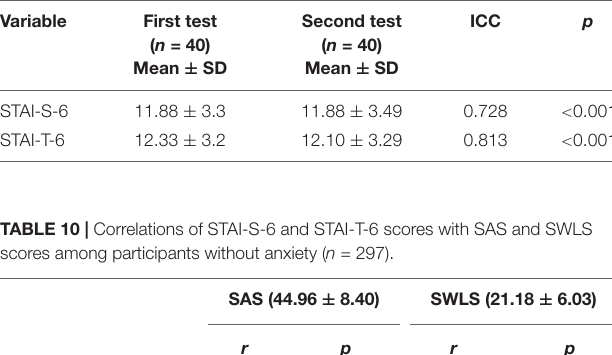
TABLE 8 | Confirmatory factor analysis (CFA) of the short-form STAI scale ( n = 1,142).